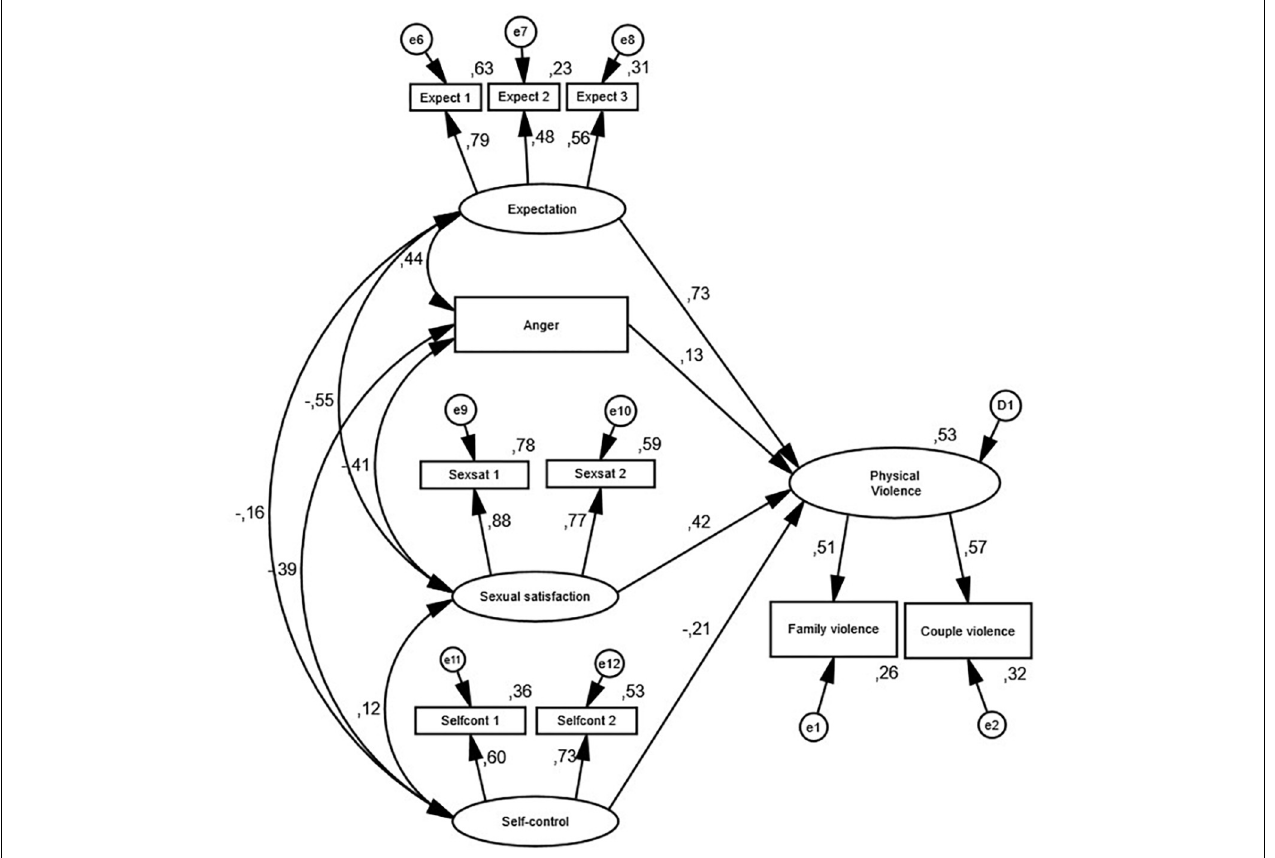
FIGURE 1 | Predictive model of Physical Violence. All covariances and factor loadings were statistically significant ( p < 0.05).